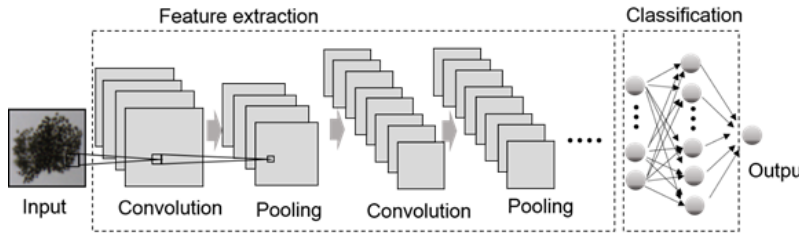
Figure 1. An illustrative example of a convolutional neural network (CNN)